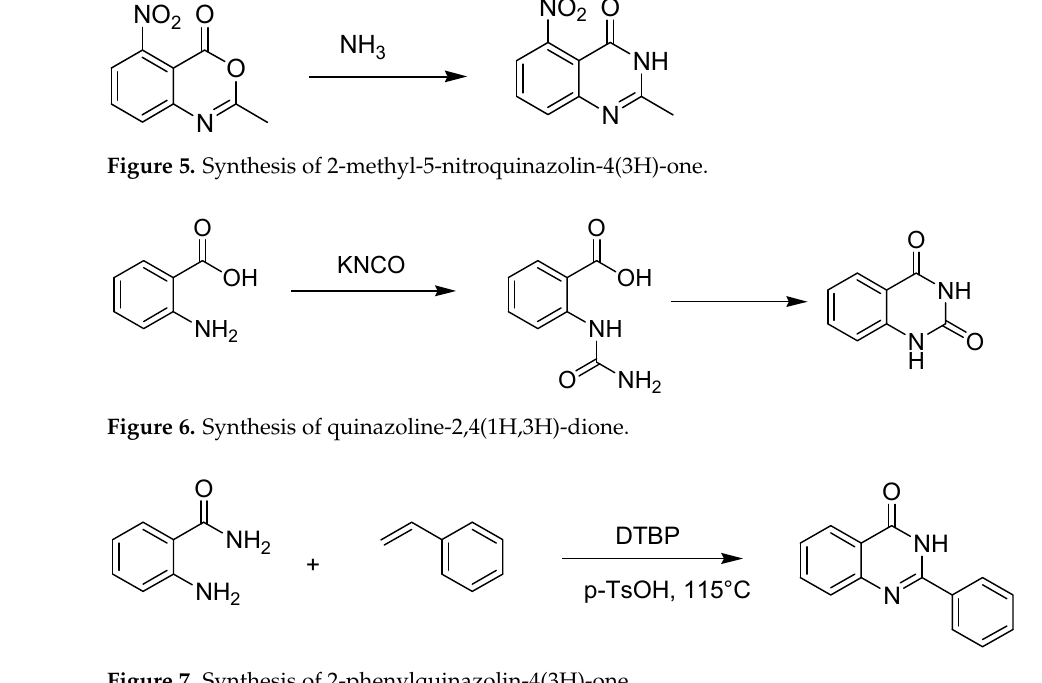
Figure 7. Synthesis of 2-phenylquinazolin-4(3H)-one.